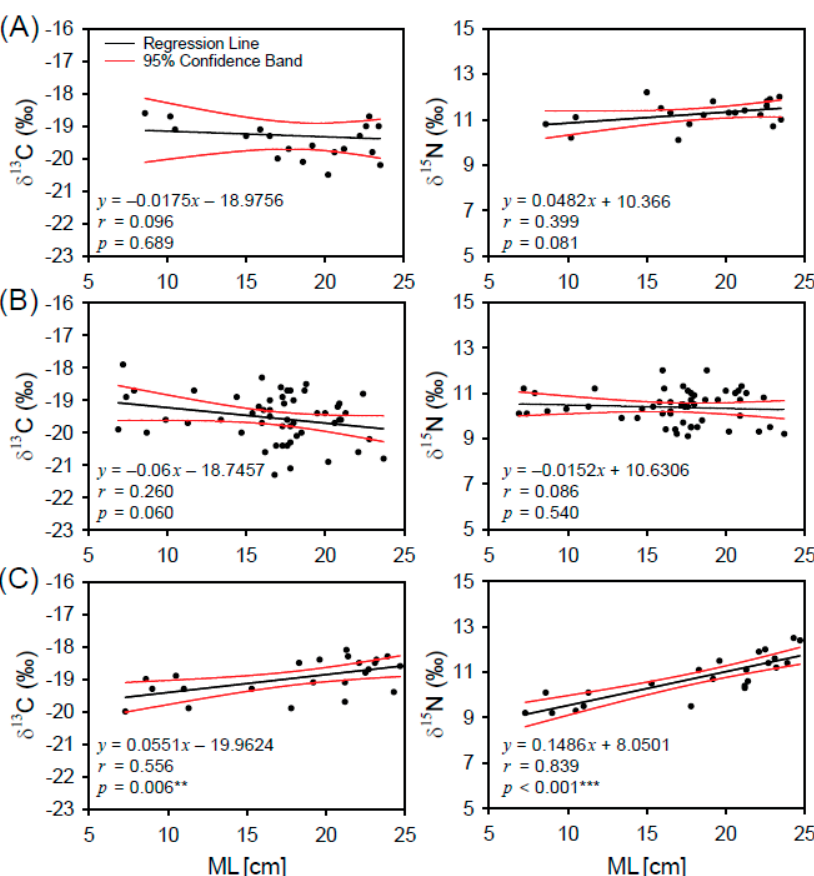
Figure 4. Regression relationships between δ 13 C—mantle length (cm, left) and δ 15 N—mantle length (cm, right) of common squid Todarodes pacificus collected in the South Sea of Korea during February (winter, ( A )), May (spring, ( B )), and August (summer, ( C )) 2021. ** p < 0.01, *** p < 0.001.